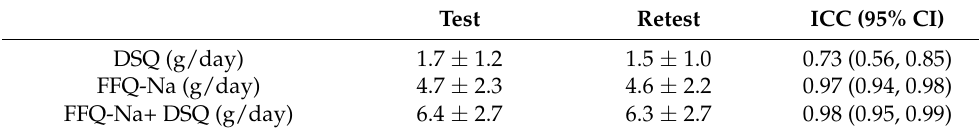
Table 1. Total salt intake assessed from the test-retest for the DSQ and the FFQ-Na ( n = 36).